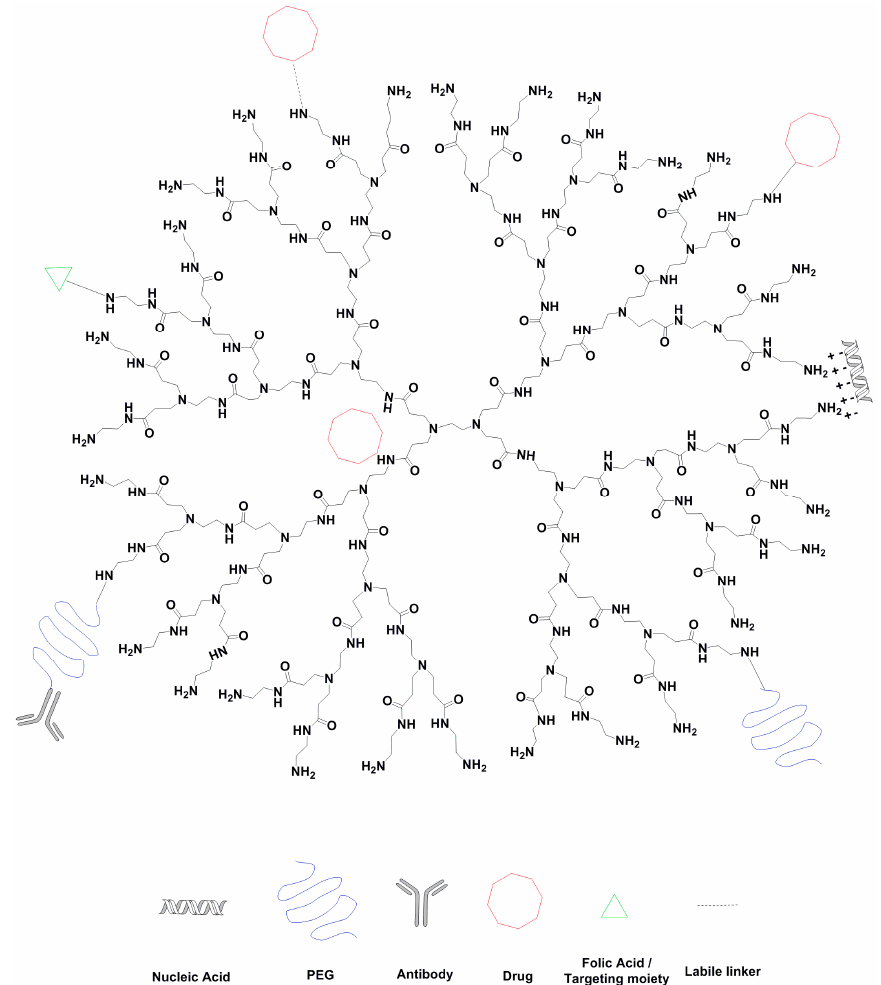
Figure 2. Schematic representation of 3G PAMAM and examples of how dendrimers can interact with drugs and nucleic acid. Also, possible surface modifications that increase tumor specificity. Illustration generated by ChemDraw Professional Version 16.0.1.4. Table 1. Physical characteristics of PAMAM and PPI dendrimers based on ideal defect-free structures Generation